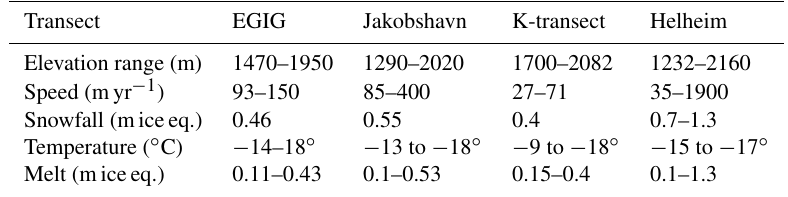
Table 1. Approximate conditions taken from RACMO2.3p2 (Noël et al., 2018) along the four transects used in the